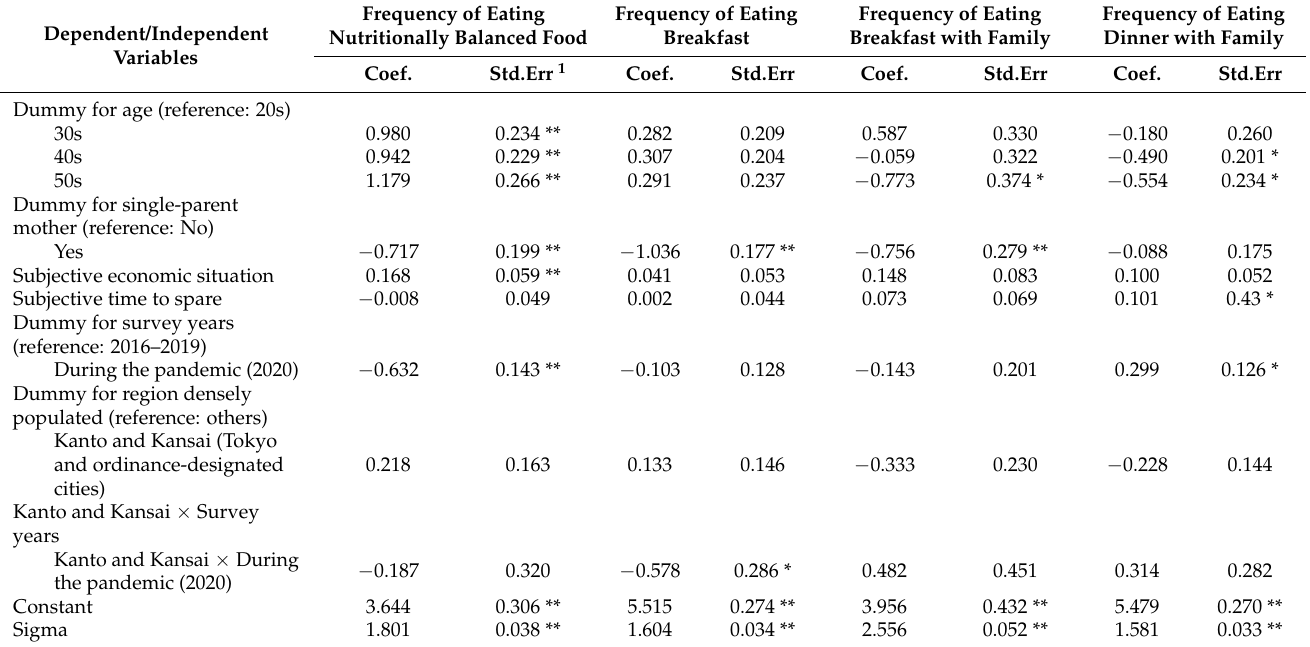
Table 4. Estimation results (interval